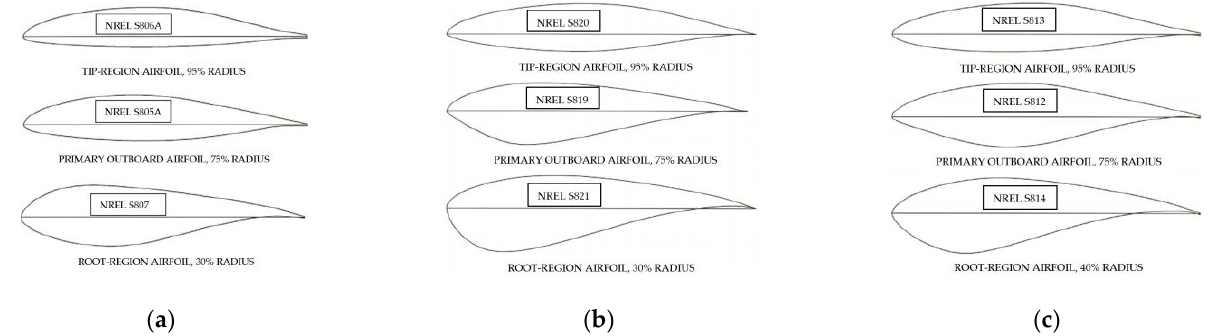
Figure 1. ( a ) Thin-airfoil family for medium blades (low tip Cl max ), ( b ) thick-airfoil family for medium blades (low tip Cl max ), ( c ) thick-airfoil family for large blades (low tip Cl max ).